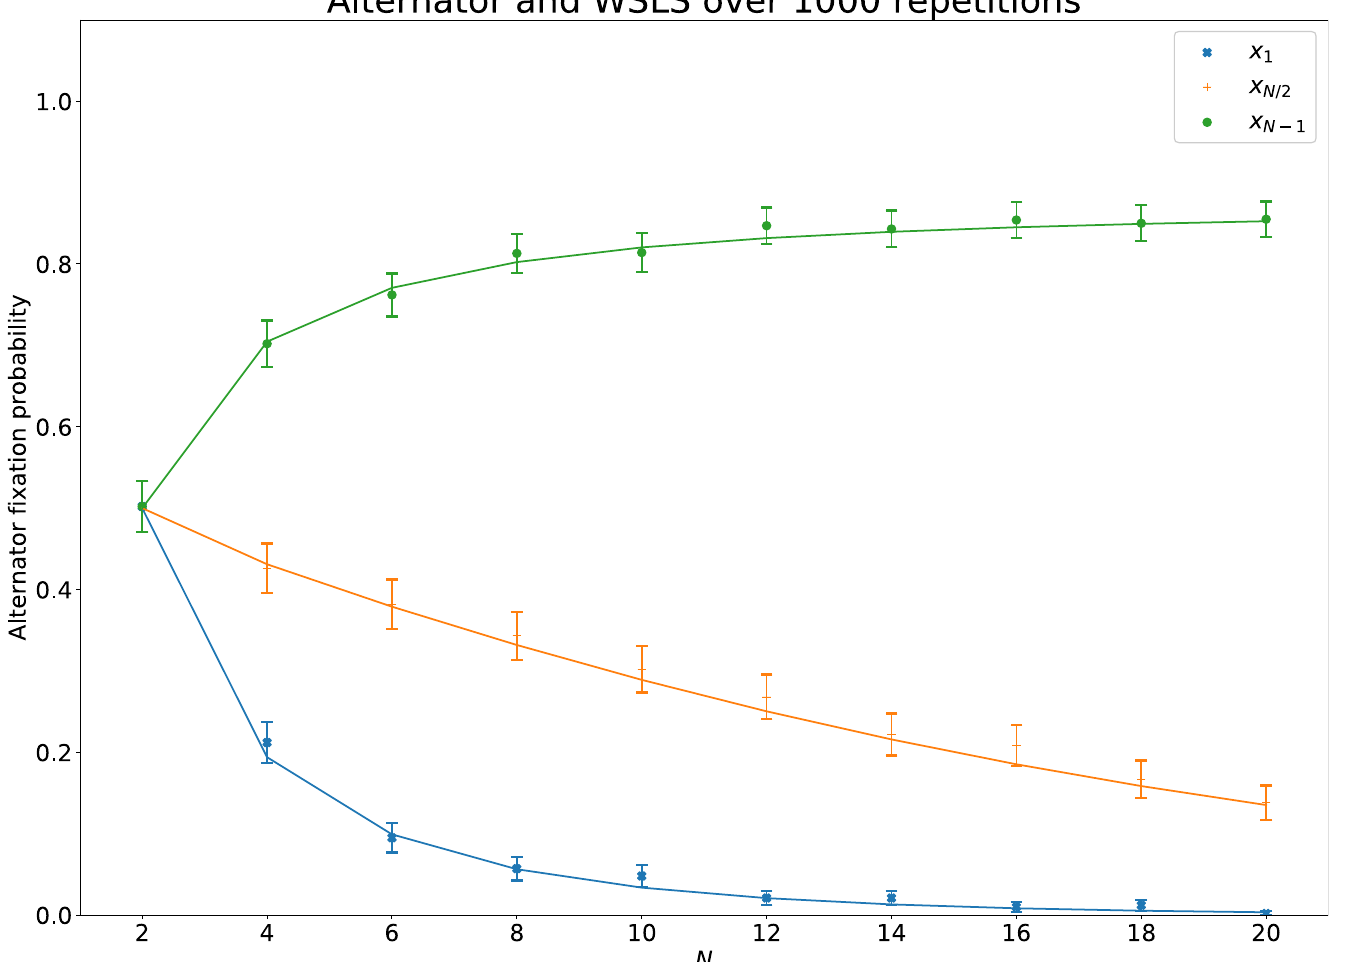
Fig 5. Comparison of theoretic and actual Moran process fixation probabilities for deterministic strategies: Alternator and Cooperator. 5% confidence intervals calculated using an asymptotic normal approximation. The top most line on all figures (in red and using a circle) corresponds to x using a cross) corresponds to x N /2 and the bottom line (in blue and using an x) corresponds to x 1 .